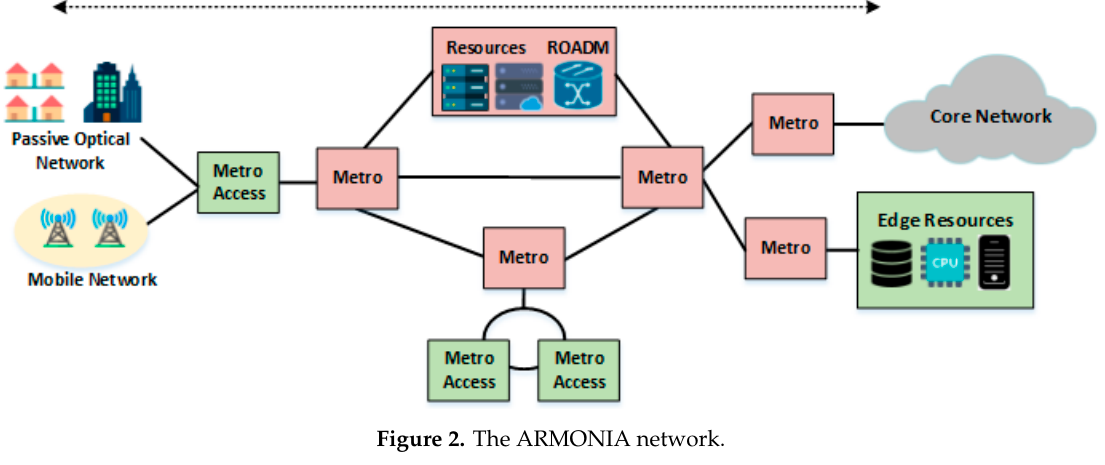
Figure 2. The ARMONIA network. Appl. Sci. 2020 , 10 , x FOR PEER REVIEW